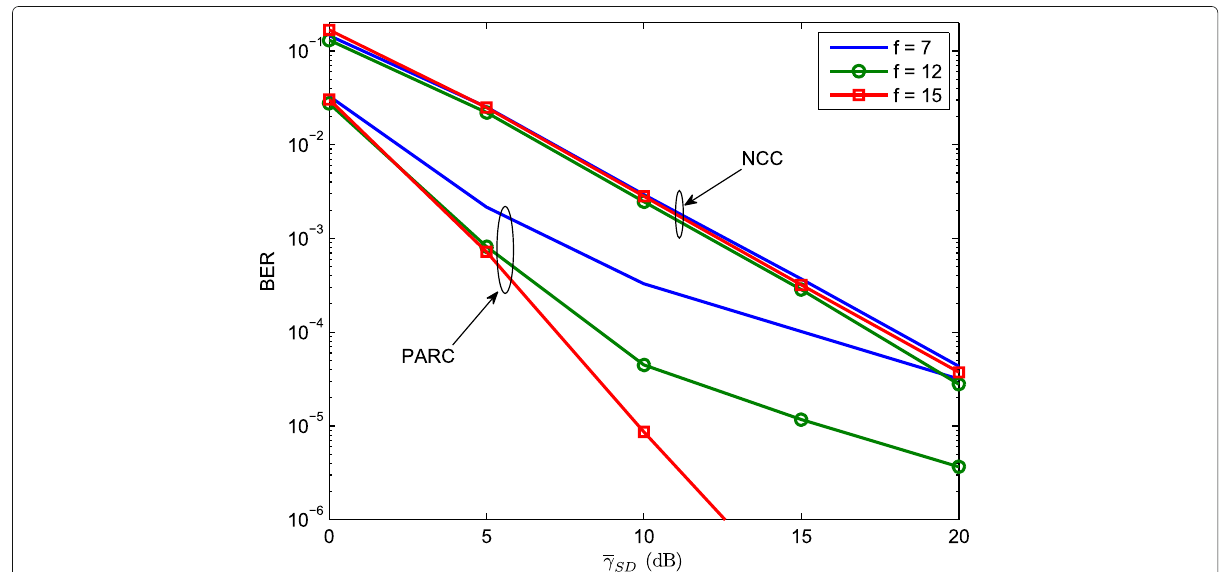
Fig. 7 Performance comparison between PARC and NCC for different minimum distances, which corresponds to code’s correction capacity. Three codes with rate 1/3 are compared: CC [5 7 5] with f = 7, CC [25 33 37] with f = 12, and CC [133 165 171] with f =